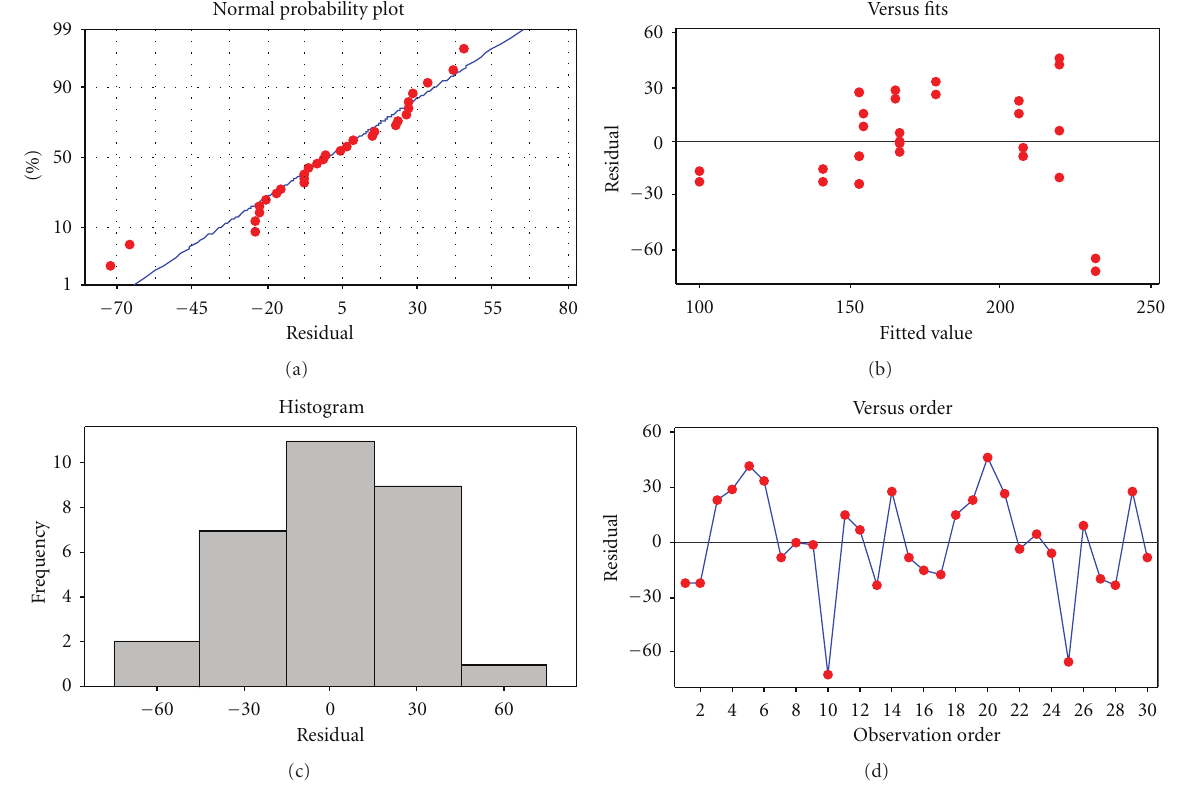
Figure 1: Residual plots for concentration of leached copper.